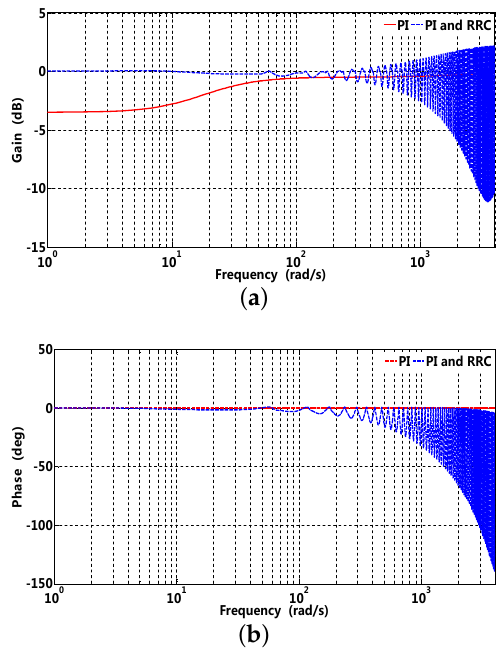
Figure 11. Gain and phase waveforms of q -axis complementary sensitivity function, where corresponding parameters are N = 1044, ω 0 = 60 rad/s, K q = 0.6, p = 3, D = 2.6 and T s = 0.1 ms, respectively. ( a ) gain; ( b )